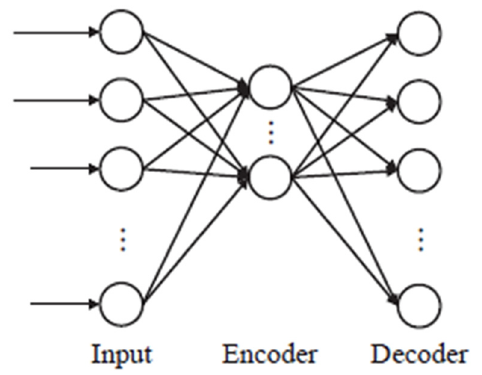
Figure 1. Autoencoder structure.